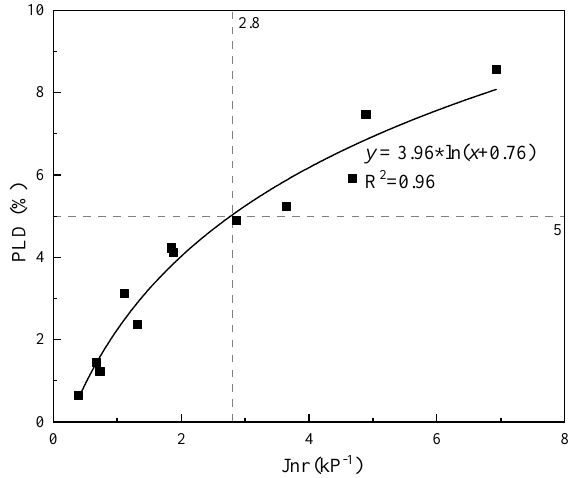
Figure 10. The relationship between J nr and